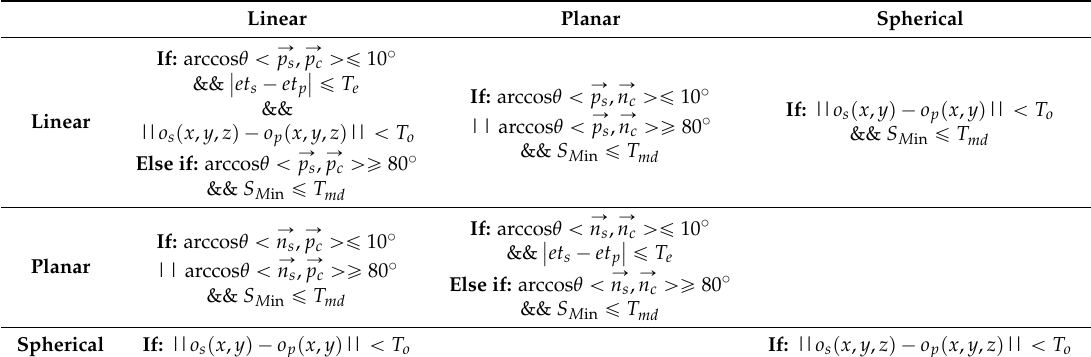
Table 1. Rule of merging adjacent voxel